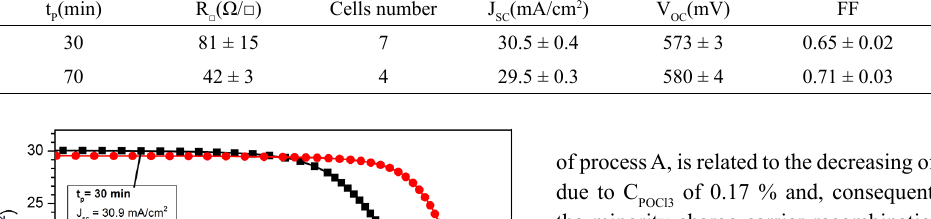
) with POCl concentration of P 3